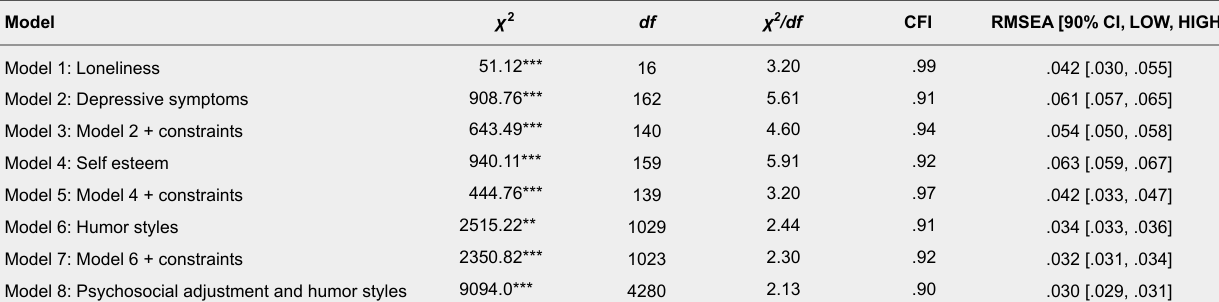
Cross-Lagged Models